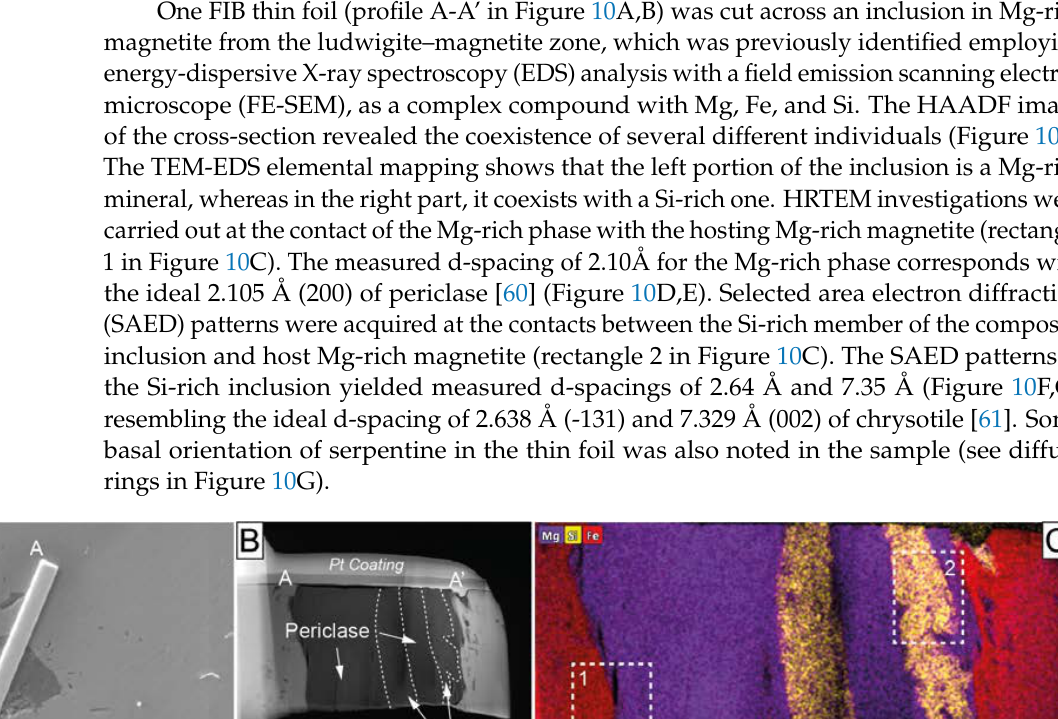
boundaries with hosting Mg-rich magnetite (Figure 11B,C). The SAED patterns were of 2.09 Å (Figure 11E) corresponds to 2.105 Å (200) of periclase. Calcite was identified by a measured d-spacing of 3.03 Å (Figure 11F) corresponding to the ideal 3.035 Å (104), as defined by Graf